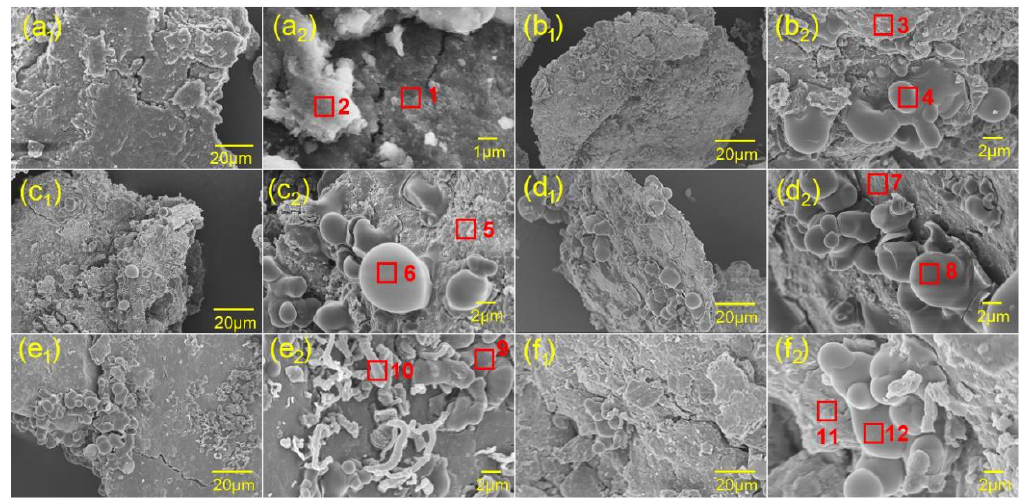
Figure 4. SEM images of active Al-LMP-NiCl 2 composites powder ( a 1 ) 0% NiCl 2 (1 h), ( a 2 ) amplified image of a 1 ; ( b 1 ) 2% NiCl 2 (1 h), ( b 2 ) amplified image of b 1 ; ( c 1 ) 4% NiCl 2 (1 h), ( c 2 ) amplified image of c 1 ; ( d 1 ) 6% NiCl 2 (1 h), ( d 2 ) amplified image of d 1 ; ( e 1 ) 2% NiCl 2 (2 h), ( e 2 ) amplified image of e 1 ; ( f 1 ) 2% NiCl 2 (3 h), ( f 2 ) amplified image of f 1 . Table 2. EDX analysis of ball-milled NiCl 2 composites (at.%). Sample